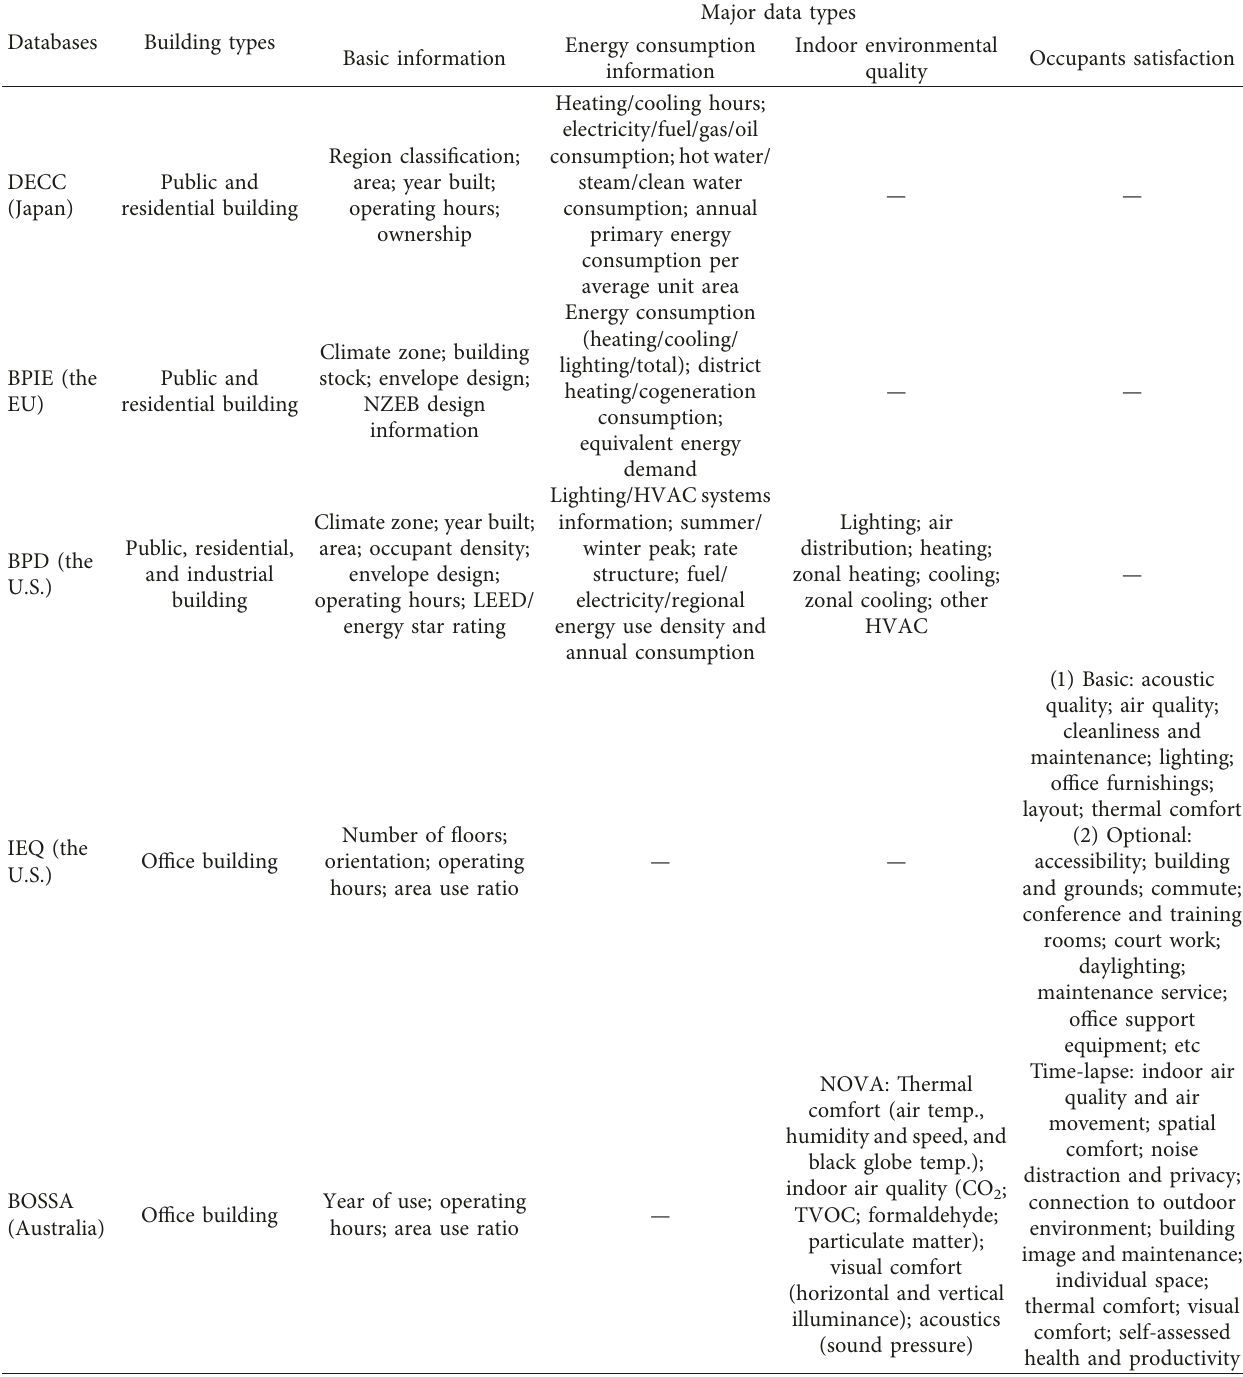
Table 1: Data types of current building performance